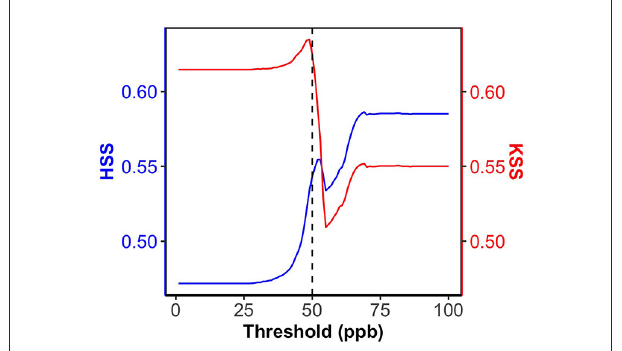
FIGURE2 The evaluations of HSS and KSS with increasing the threshold.